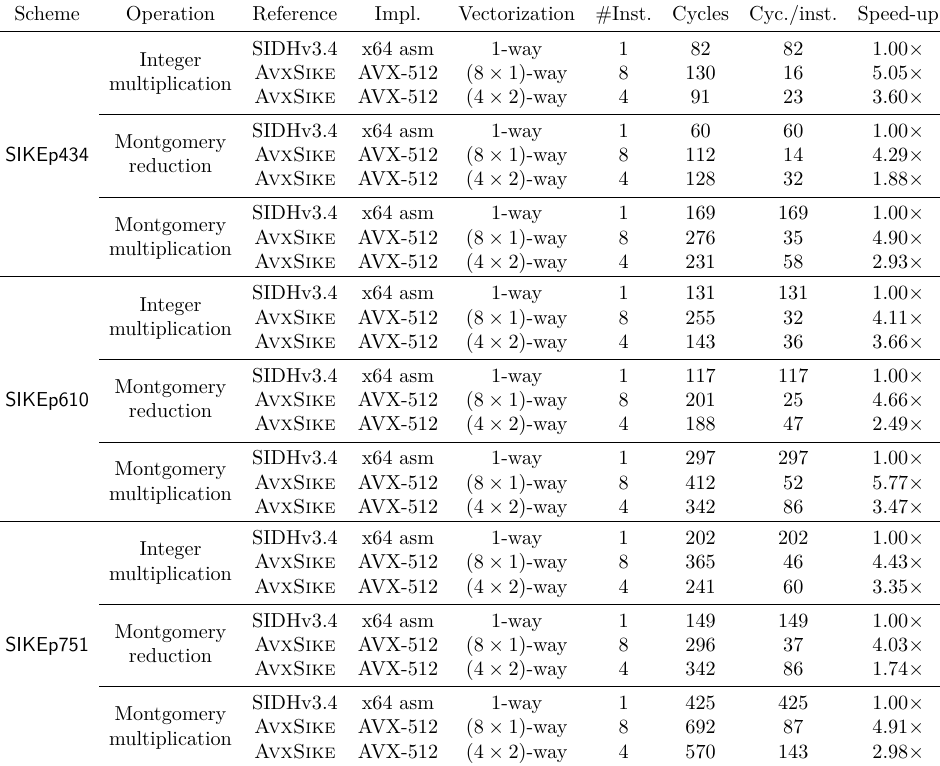
Table 7: Benchmarking results of F p -arithmetic operations.